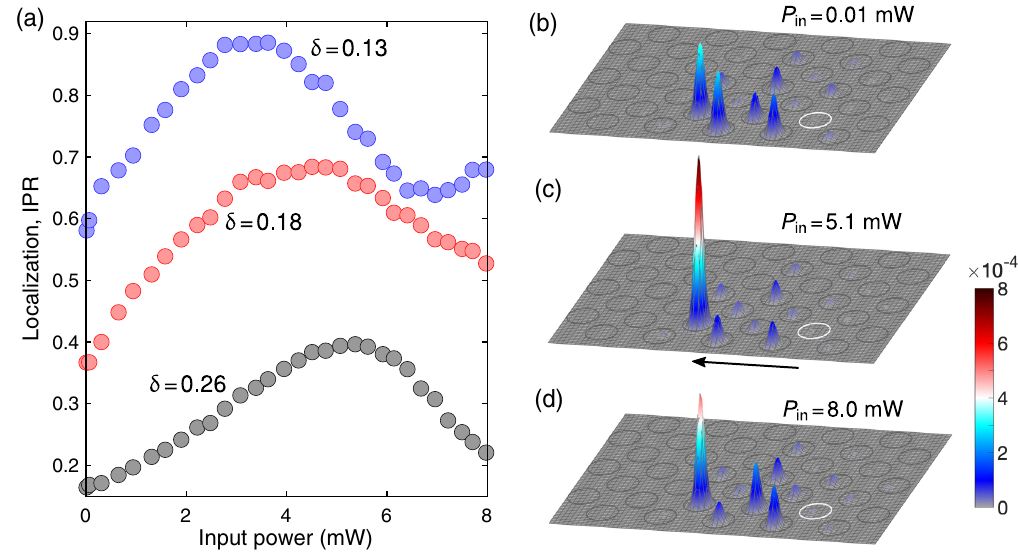
FIG. 3. Observation of solitonlike states traveling unidirectionally along the edge of the topological lattice. (a) Experimentally measured inverse participation ratio at z ¼ 2 z 0 for δ ¼ f 0 . 13 ; 0 . 18 ; 0 . 26 g — for all cases, a clear peak in the IPR is visible. (b) – (d) Output intensity distributions for δ ¼ 0 . 26 measured at three different power values indicated in each image. The input state propagates two unit cells along the bottom edge with minimal spreading when the average input power is P image indicates the lattice site where light is launched at the input. Each image is normalized, and the field of view is smaller than the lattice size.